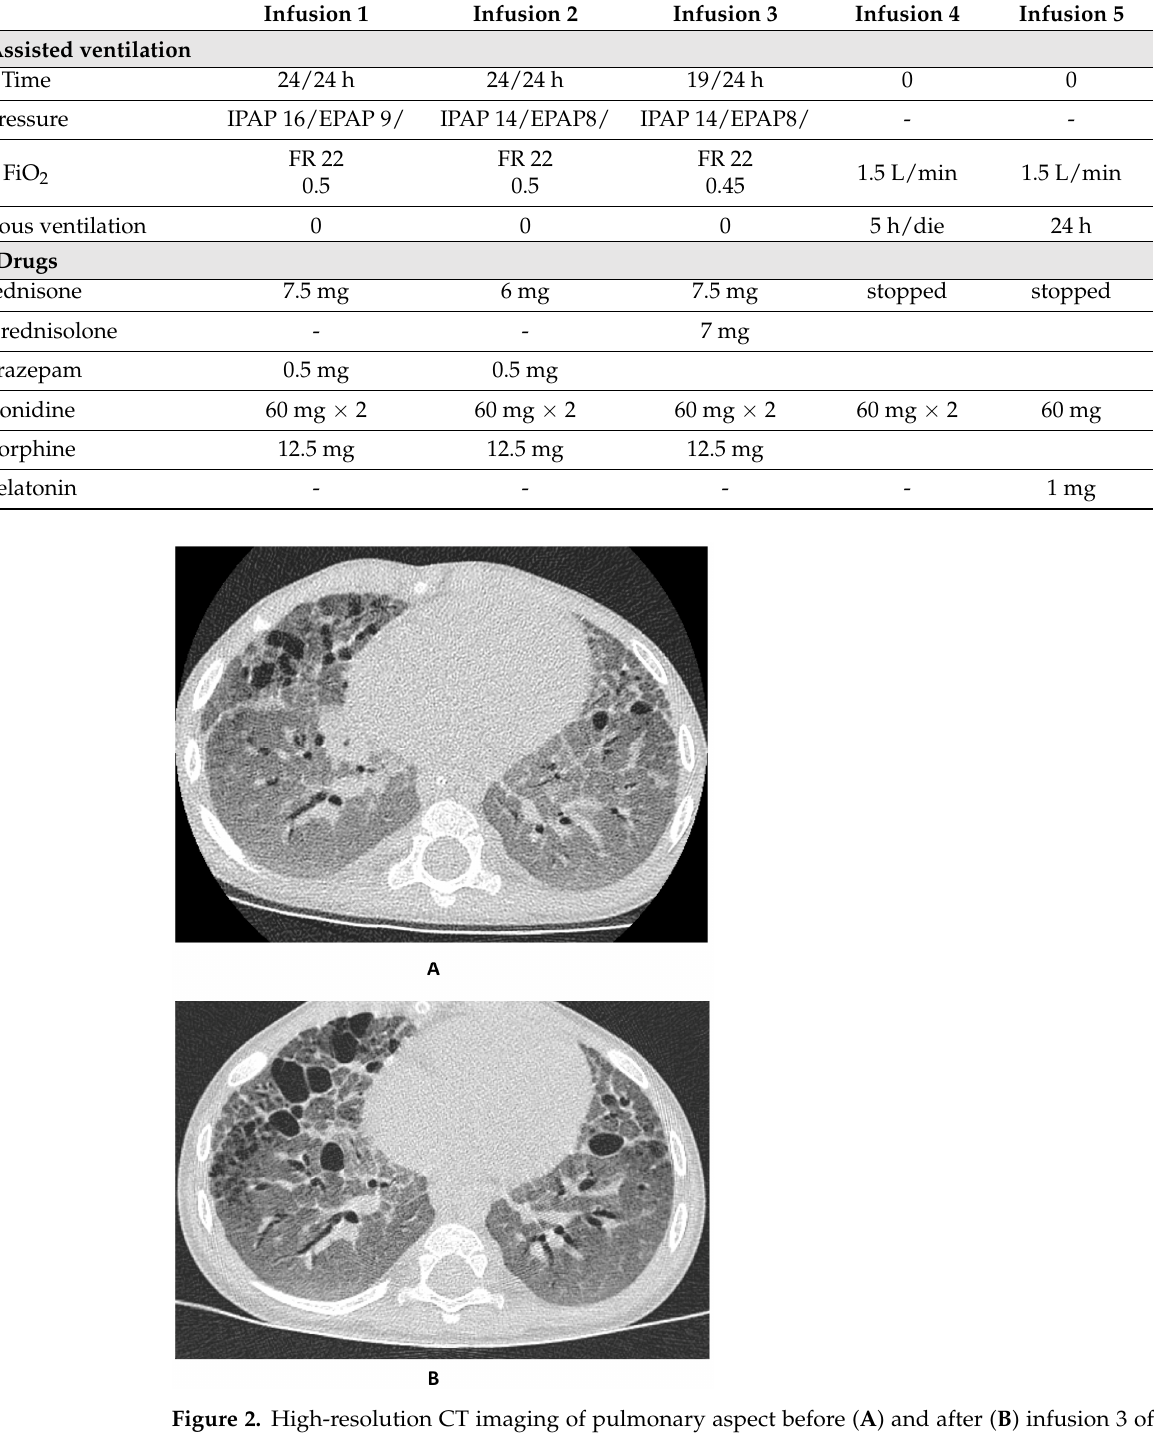
Figure 3. Chest X-ray pulmonary aspect before infusion 1 ( A ) and infusion 5 ( B ) of mesenchymal stromal cells.